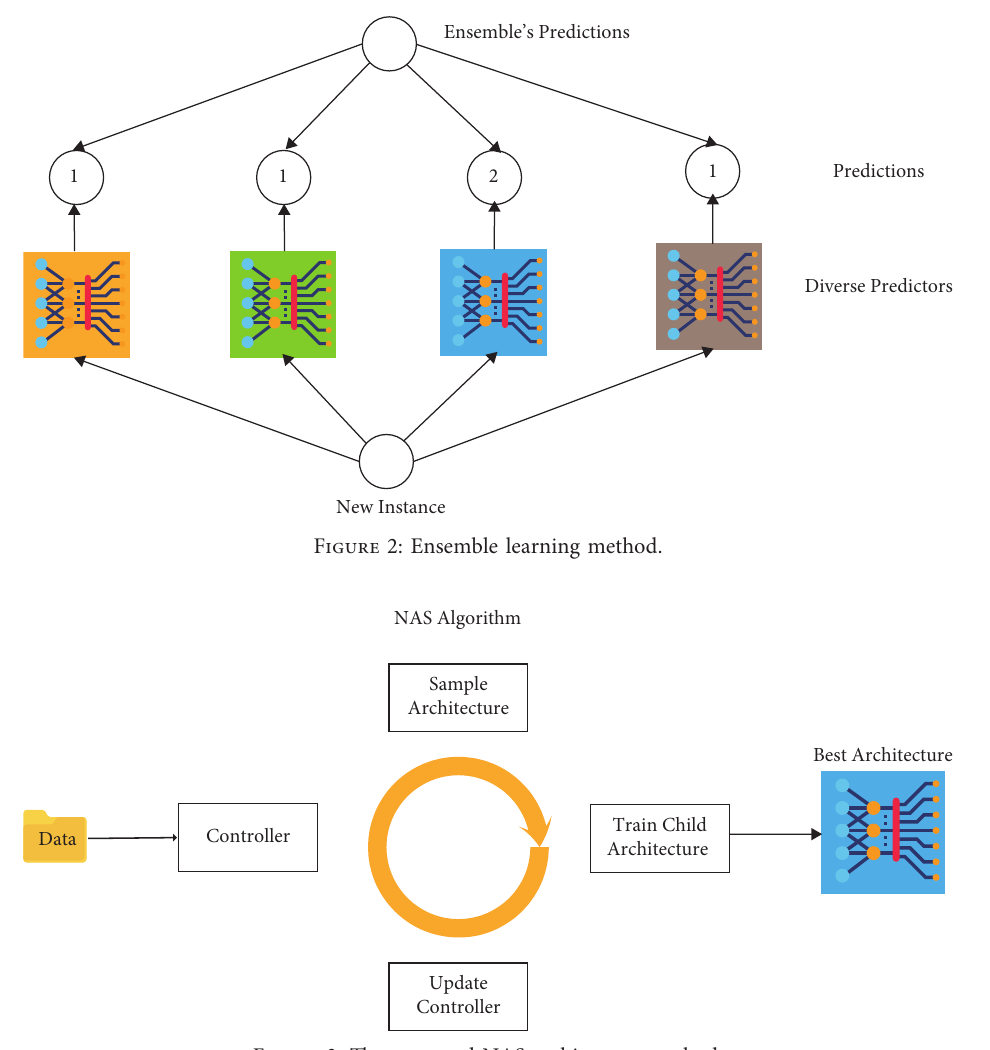
Figure 3: The proposed NAS architecture method.